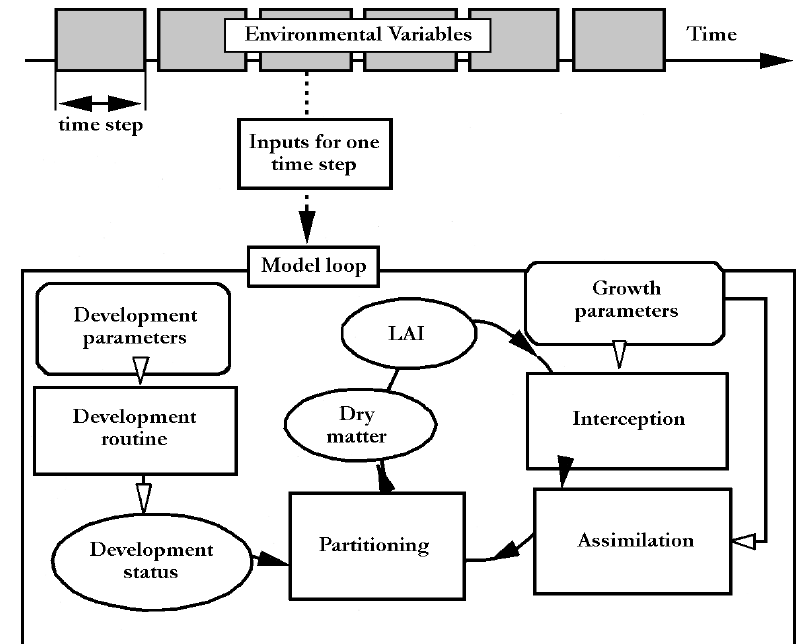
Figure 7. Simplified scheme of a crop process model. Model state variables such as development phase, organ dry mass, or leaf area index are linked to input variables, including weather, and geographic and management variables (from Delecolle et al.